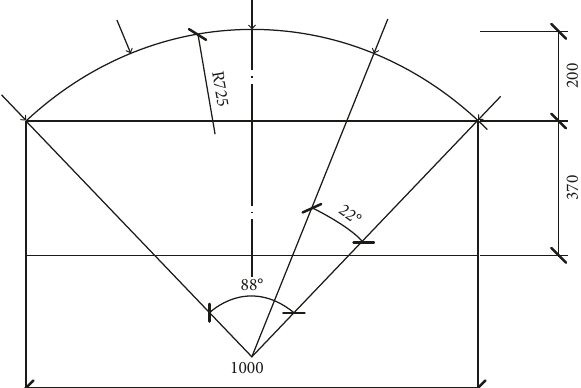
Figure 2: Model dimensions and gauge positions (units: mm).